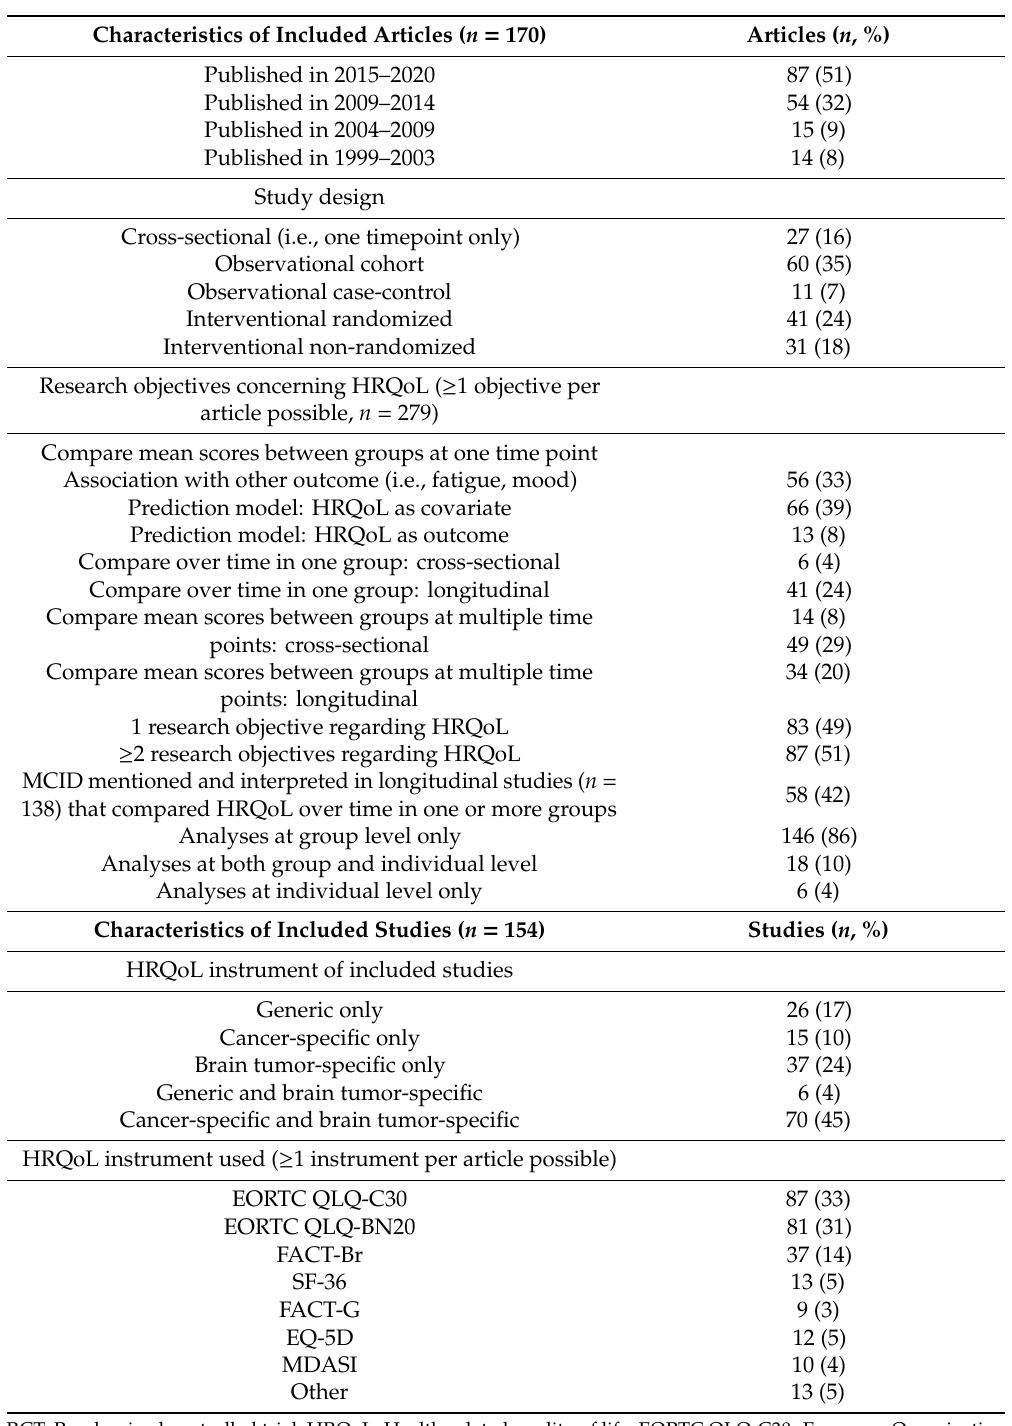
Table 1. Characteristics of the included articles and